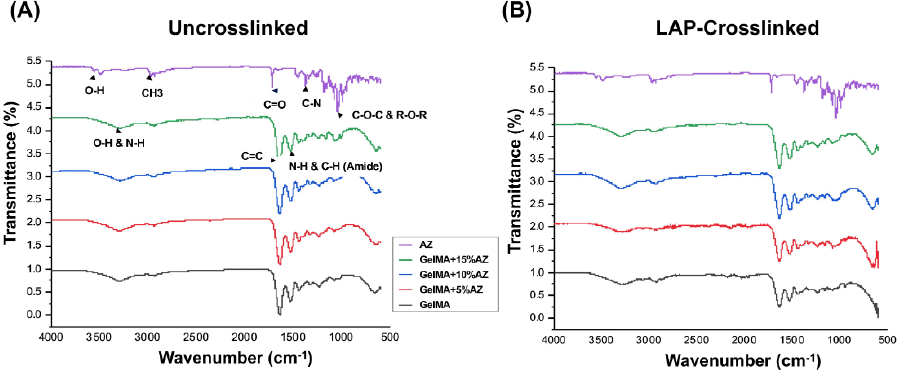
Figure 2. Fourier transform infrared spectroscopy (FTIR) spectra of ( A ) uncrosslinked and ( B ) crosslinked GelMA-based fibers.